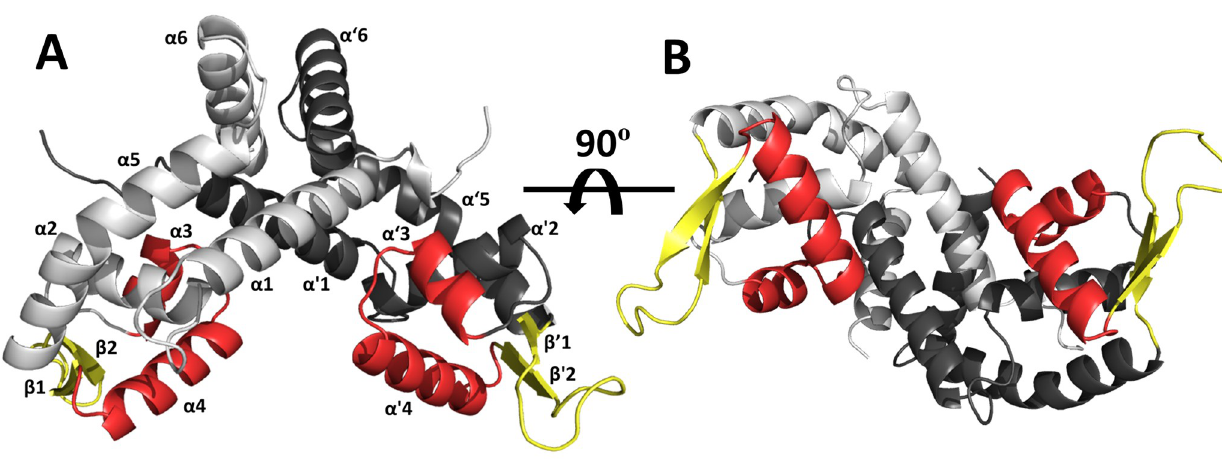
Fig 1. The BpsR structure. (A) The monomers of the BpsR dimer are highlighted in light and dark gray, and the secondary structures are labeled ( α / α ‘ 1–6 and β / β ’ 1–2). The conserved winged Helix-turn-Helix (wHtH) domain is highlighted showing the helices in red and the beta hairpin in yellow. (B) The BpsR dimer is rotated 90 º , showing the DNA binding